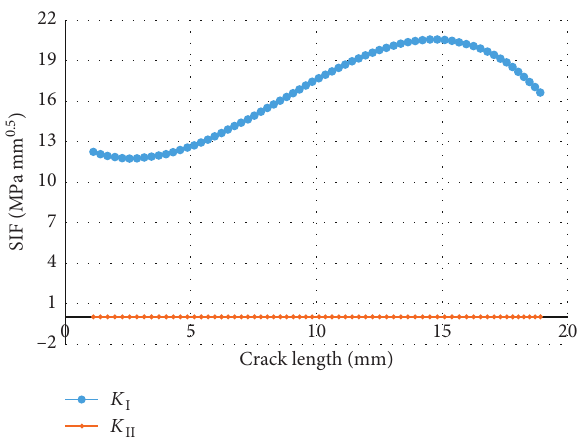
Figure 15: Relationship between SIFs and crack length for crack 1.